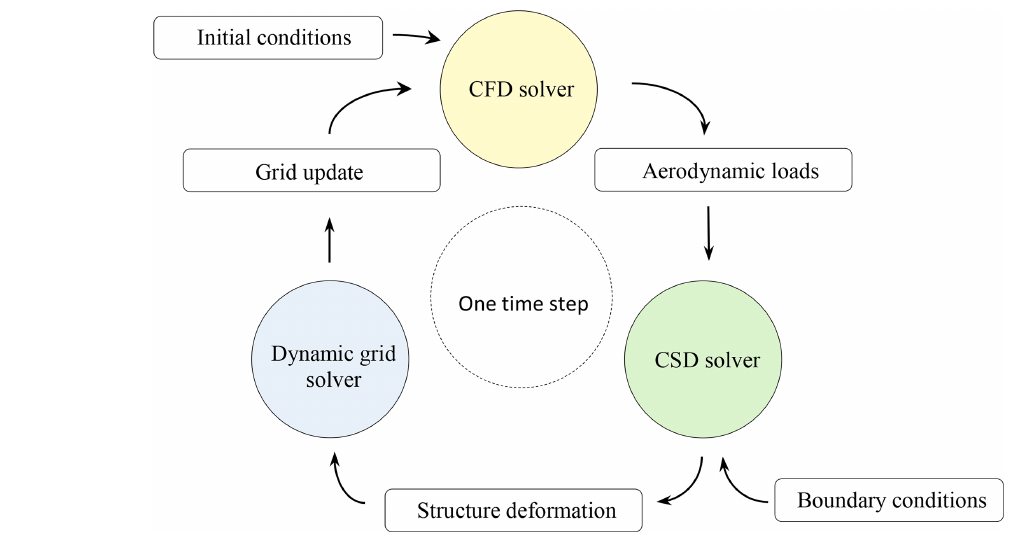
Figure 1. CFD-CSD coupling scheme.